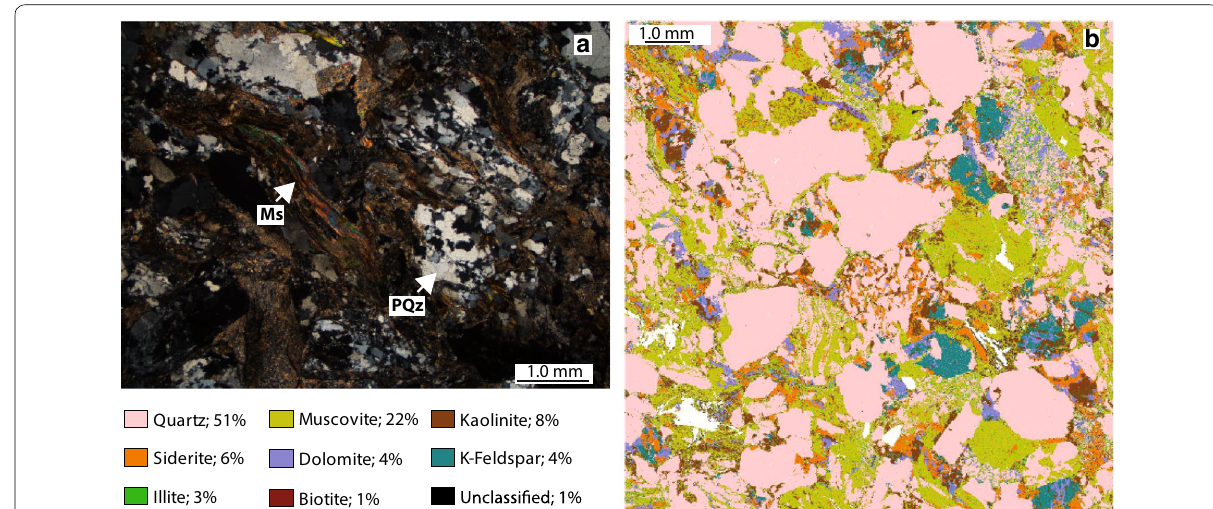
Fig. 5 The preliminary petrographical features of Permo-Carboniferous sediment (sample HU27; depth: 3037.45 m) including documentation of very coarse and partially dissolved detrital polycrystalline quartz grains (PQz) and muscovite (Ms). Stress resulted in the deformation of quartz grains into domains with slightly different extinction angles (left image; a ). The Kaolinization of K-feldspar is occurring to form the clay cement for pore-filling and grains coating of the component grains; QEMSCAN analysis (right image; b ). Minerals with volume < 0.5% were not